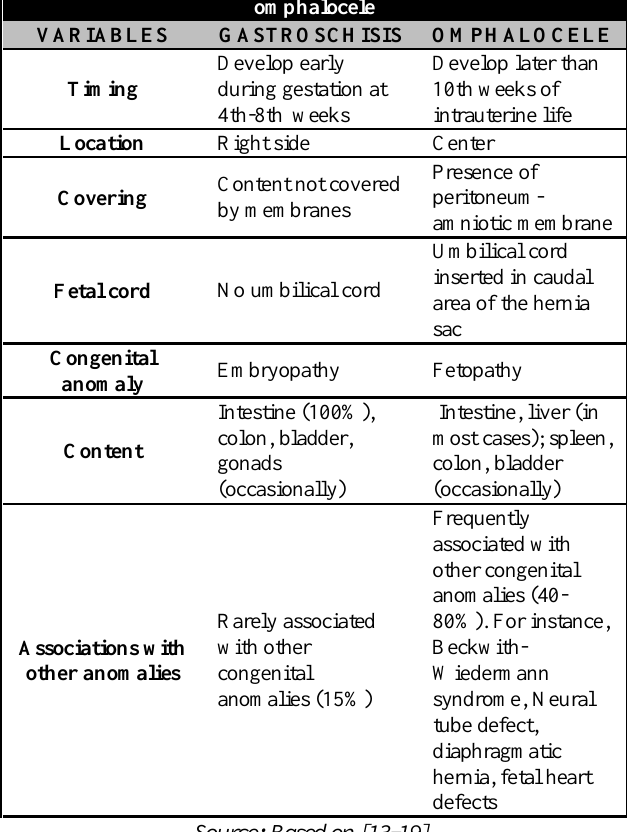
Table 1. Classical differences between gastroschisis